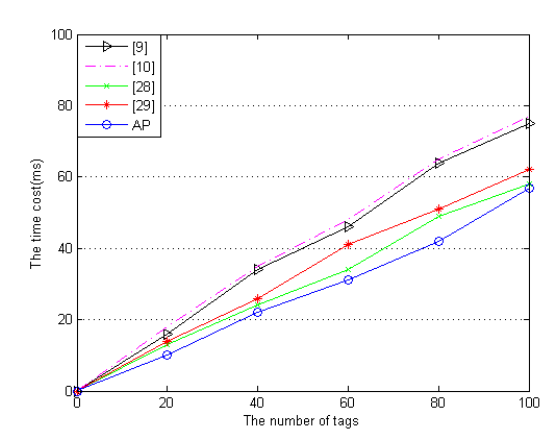
Figure 4. Time cost comparison of these